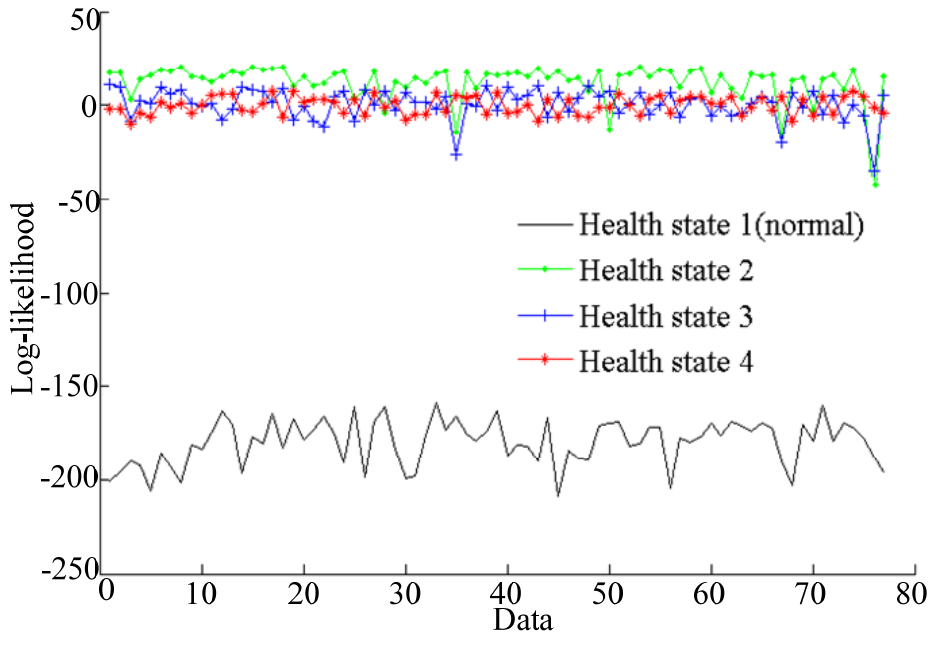
Figure 9. Log-likelihoods for the four state HMMs of the test